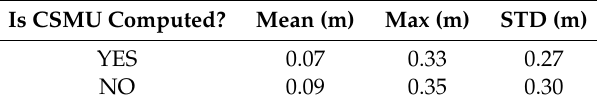
Table 1. Influence of combined standard measurement uncertainty (CSMU) on boresight calibration: average (mean), maximum (max) and standard deviation (STD) of point cloud thickness computed on a 1 m resolution grid. Note that these values are relative to a Sick LiDAR system, exhibiting a level of CSMU of about 4 cm, thus leading to a point thickness value of about 15–18 cm. The STD value is an average value, which take into account the presence of vertical structures for which it is greater. When no CSMU is taken into account, we observe that on this dataset, the STD increases by about 10%. Is CSMU Computed? Mean (m) Max (m) STD (m) YES 0.07 0.33 0.27 NO 0.09 0.35